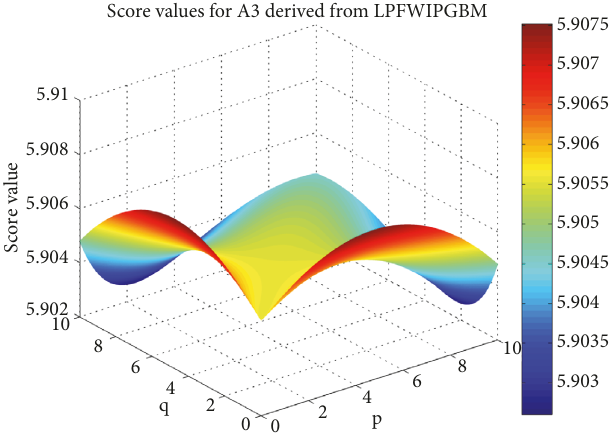
Score values for A3 derived from LPFWIPGBM